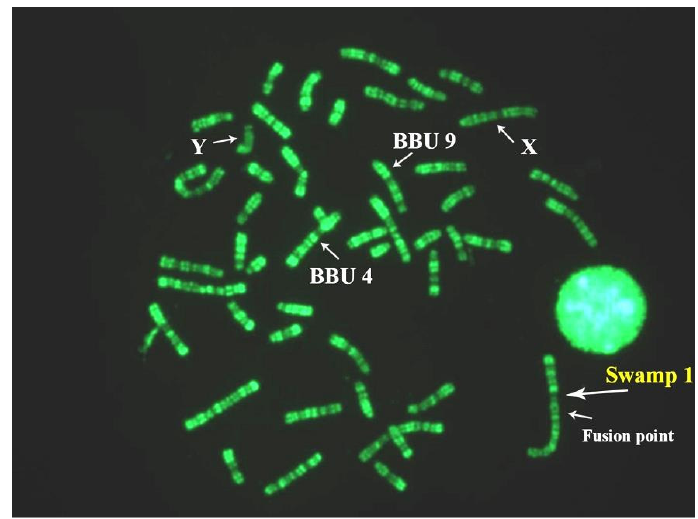
Figure 4. RBA-banding in a metaphase plate of a hybrid river–swamp buffalo (2n = 49). BBU4, BBU9, swamp chromosome 1, X, and Y chromosomes are indicated (arrows).